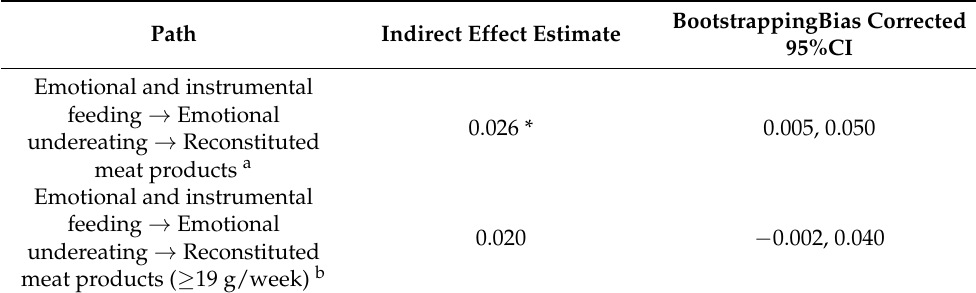
Table 6. The mediation effect of children’s emotional undereating on the associations between caregivers’ emotional and instrumental feeding and children’s consumption of reconstituted meat products ( n =